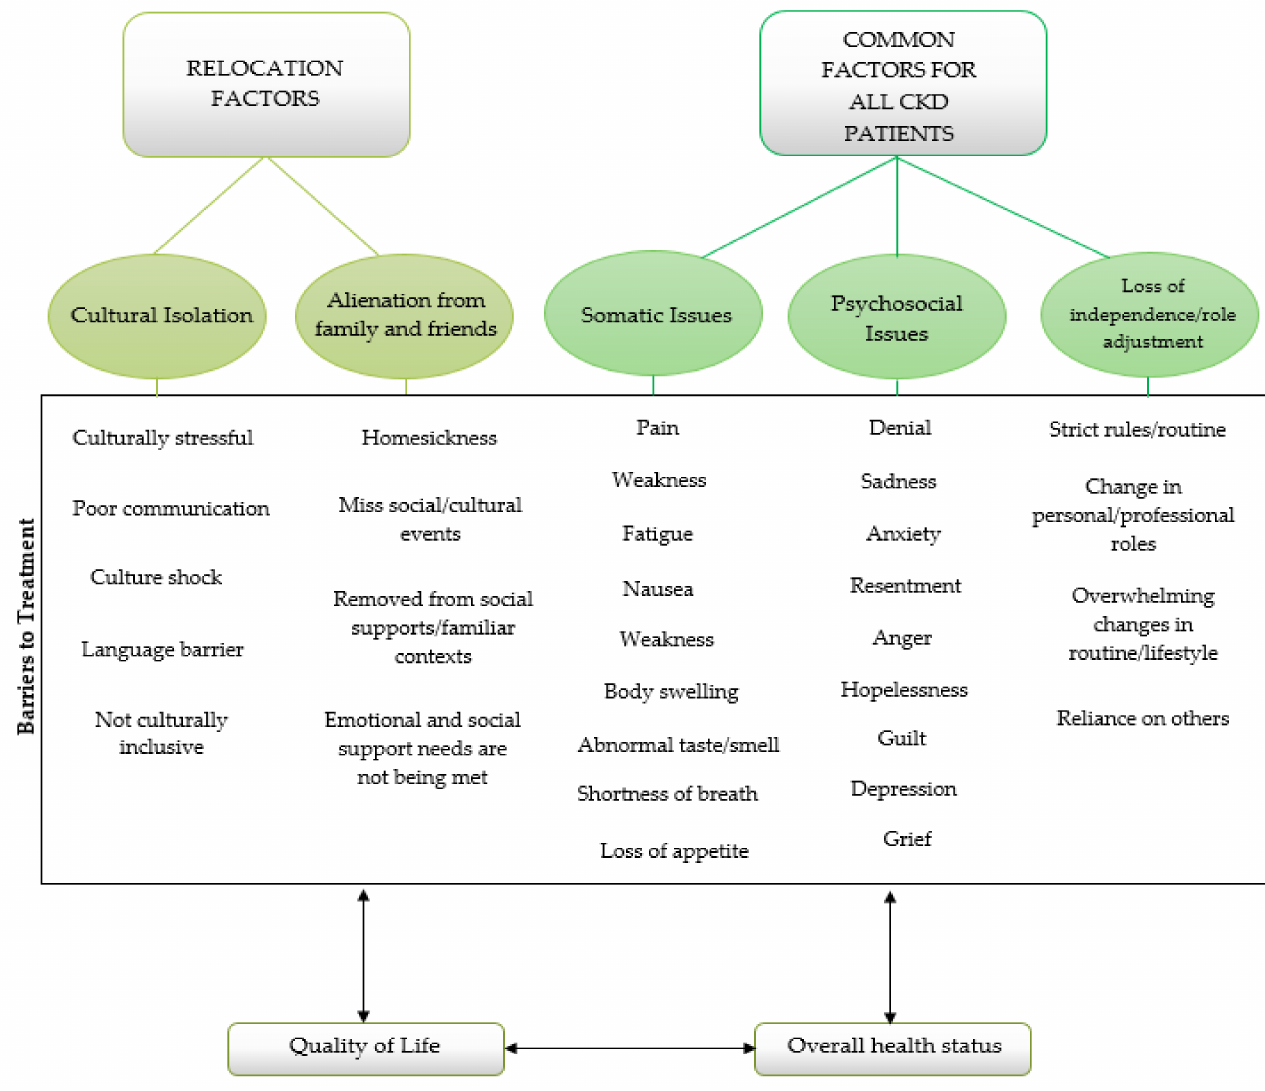
Figure 2. Interconnectedness of the effects of relocation and health